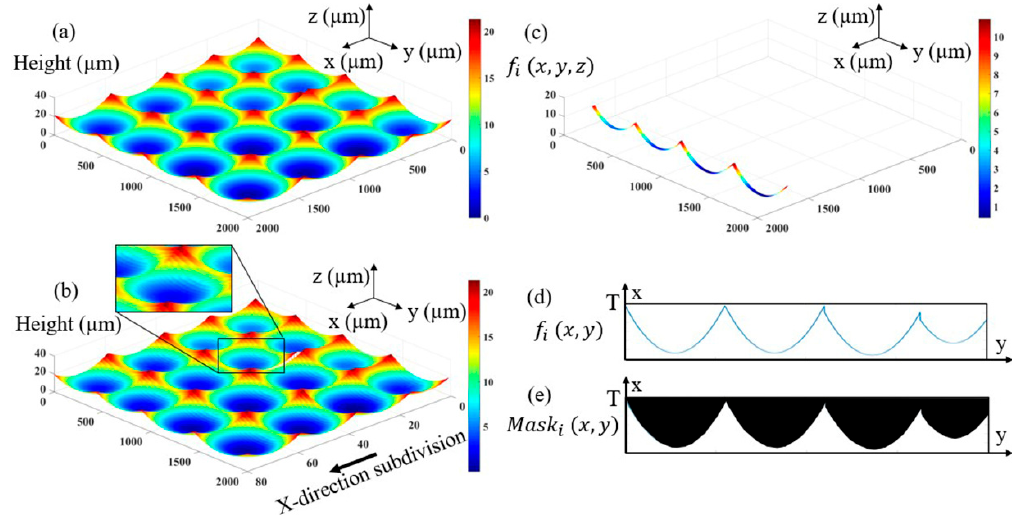
Figure 3. Degumming surface shape: ( a ) 3D contour; ( b ) 3D contour subdivision; ( c ) Spline surface distribution; ( d ) Spline 2D contour; ( e ) Mask cell pattern.